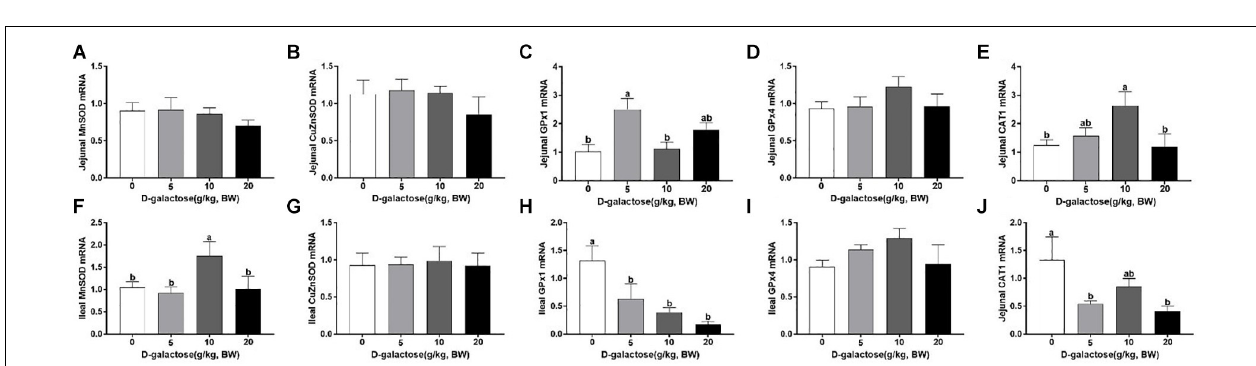
FIGURE 10 | Effects of D -galactose on the level of MDA and activities of antioxidant enzymes. (A) MDA; (B) GSH-Px; (C) CAT; (D) SOD. Data were expressed as the mean ± SEM. Different lower-case letters indicate a significant difference among different dosage of D -galactose ( P < 0.05).